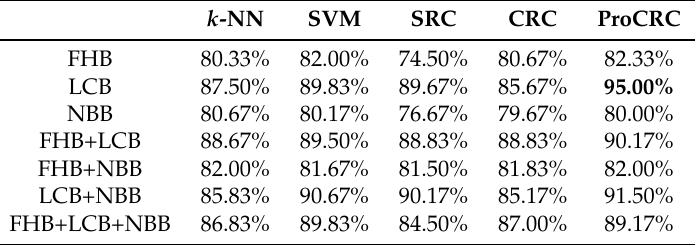
Table 2. Accuracies of the five classifiers.